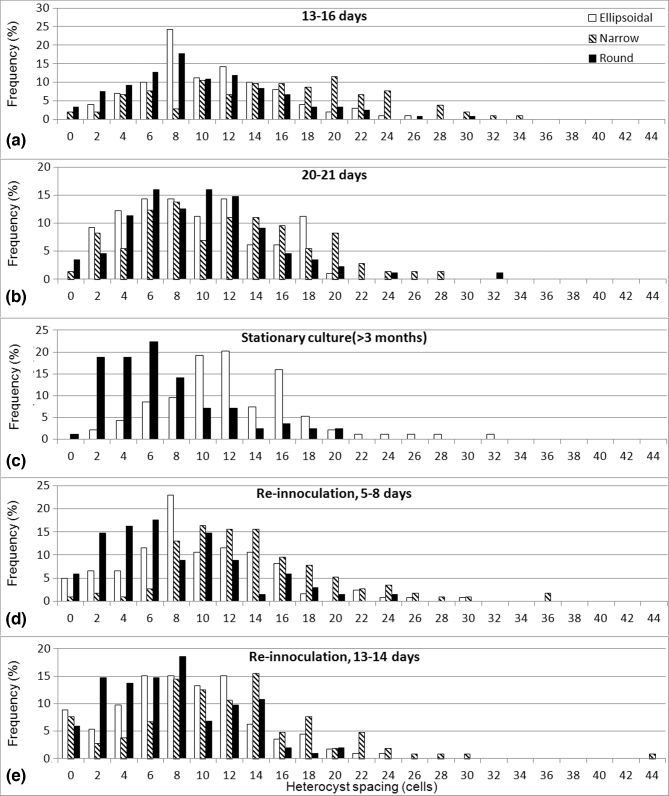
Heterocyst spacing pattern in M. laminosus at different time points
after nitrogen deprivation: (a) 13–16 days, (b) 20–21 days
and (c) more than 3 months (stationary culture). Cells from a stationary
culture were then used to inoculate new nitrogen-free media and heterocyst spacing
patterns were determined after 5–8 days (d) and 13–14 days
(e). Cells were grouped in narrow, ellipsoidal and round. Y-axis
represents percentage out of all filaments counted for the given time range. A total
of 321 filaments were counted for (a); 259 for (b); 179 for (c); 306 for (d); 318 for
(e).